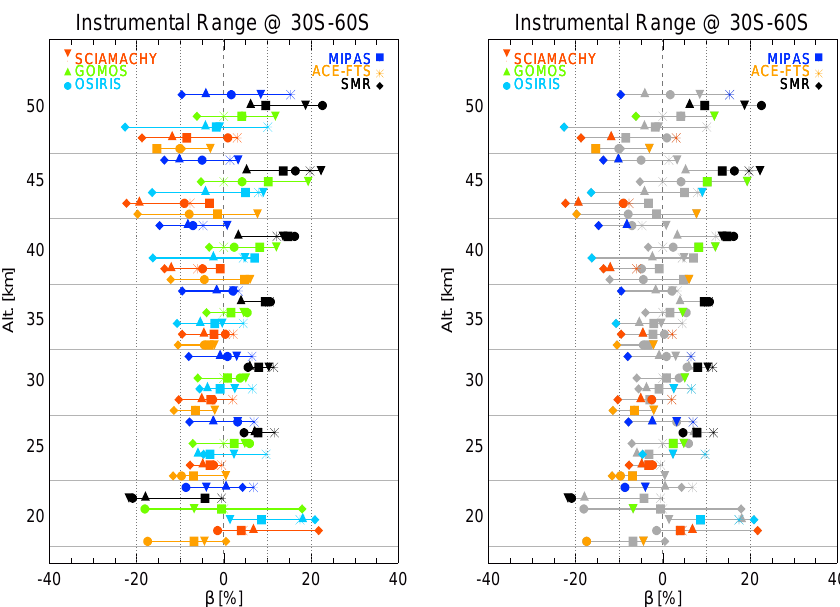
Figure 6. Same as Fig. 4 but for the southern middle latitudes (30–60 ◦ S).